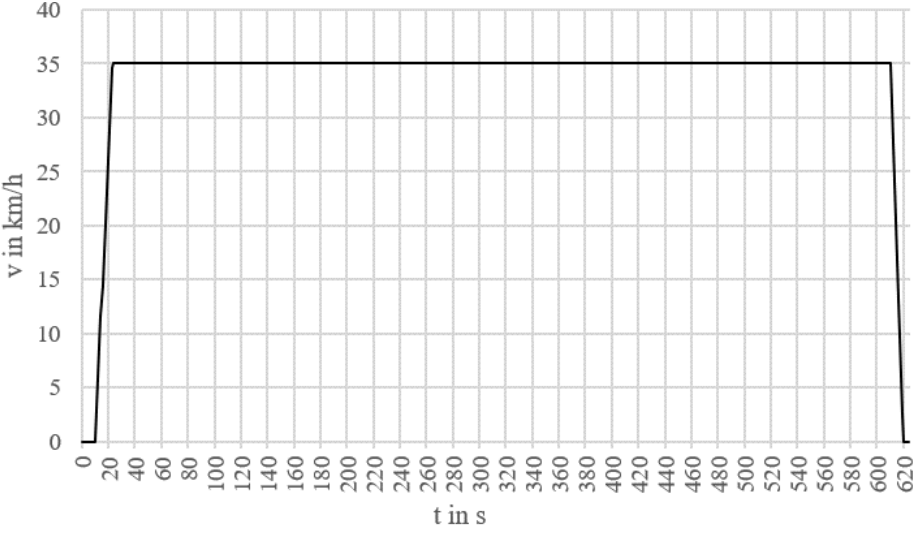
Figure 2. 35 km/h speed